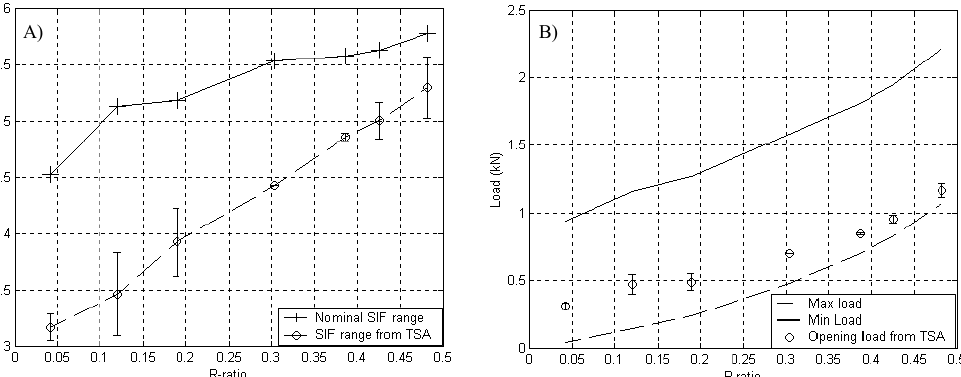
Figure 8: A) Plot showing the variation of Δ K with the R -ratio for a sequence of thermoelastic images corresponding to a 42 mm crack. B) Plot illustrating the variation with the R -ratio of the opening load inferred from a sequence of thermoelastic